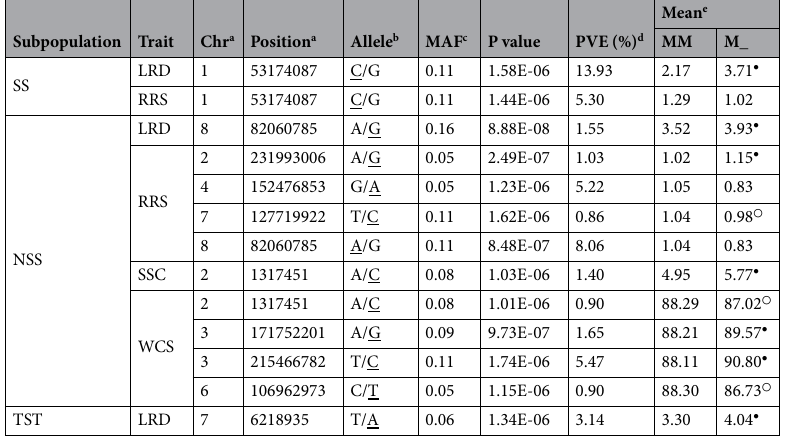
Table 3. Subpopulation-specific significant loci for the four chilling tolerance traits. a–e See footnotes of the Table 2 for